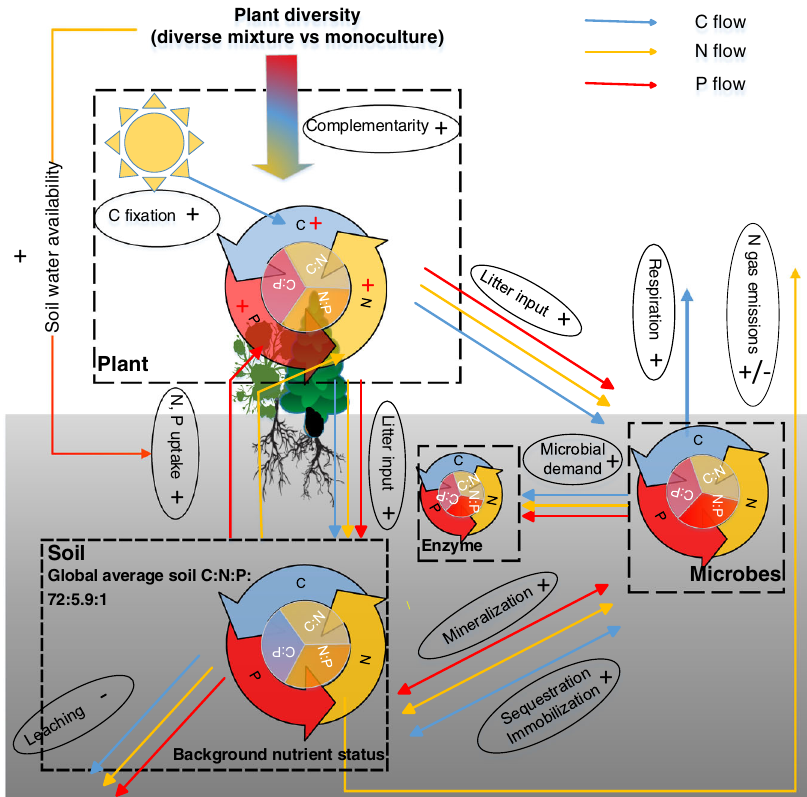
Fig. 1 Conceptual diagram of the in fl uences of plant diversity on the processes that control the C:N:P ratio of plants, soils, soil microbes, and enzymes. Ovals indicate biogeochemical processes; arrows indicate C, N, and P fl ows between plant, soil, soil microbe, and enzyme, and arrow colors indicate the elements associated with these processes (blue: C; yellow: N; red: P). Symbols “ + ” , “ − ” and “ + / − ” represent expected positive, negative, and unclear diversity effects on the processes. The weighted averages of soil C:N, C:P, and N:P ratios of monocultures in each study as proxies for the status of background nutrients. As a remarkably consistent C:N:P ratio (72:5.9:1, mass-based ratios) has been observed at the global scale 30 , we de fi ne balance